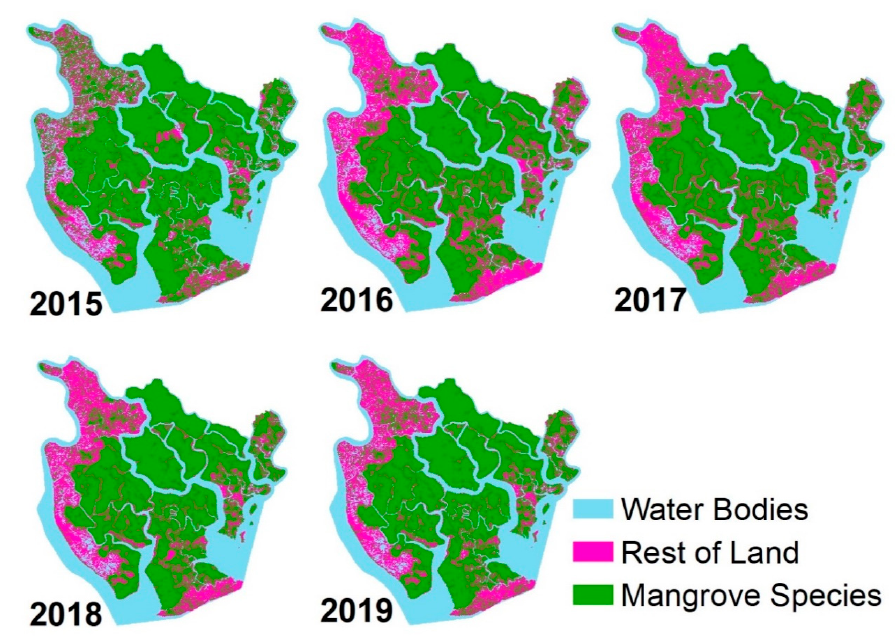
Figure 4. The change in types of land cover based on the annual NDVI classifications from 2015 to 2019.